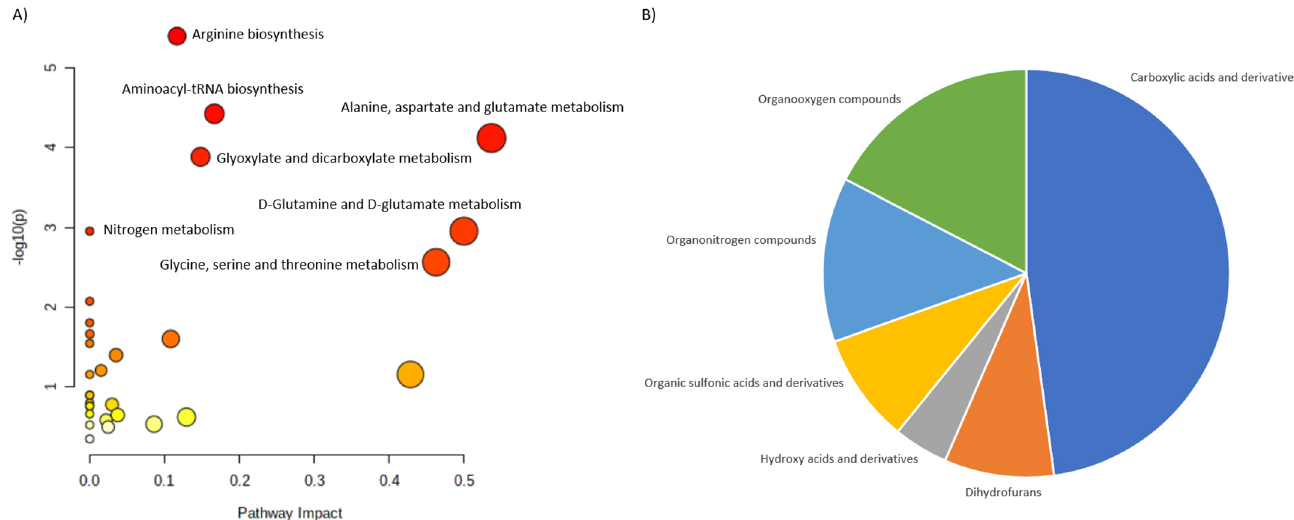
Figure 2. Characterization of metabolites altered in PHPT. ( A ) shows the main pathways, built for the discriminating metabolites reported in review publications. ( B ) shows pie chart, illustrating the distribution of the discriminating metabolites across different metabolite